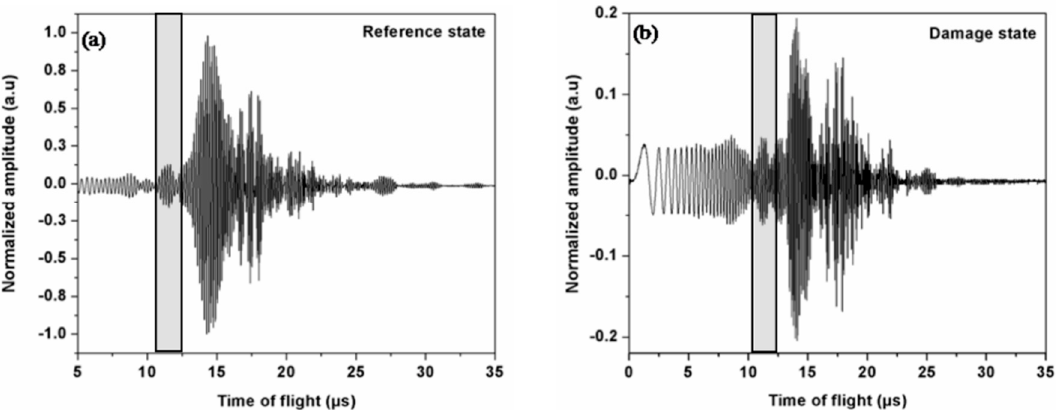
Figure 4. The transient signal of the ultrasonic wave ( a ) in reference and ( b ) damaged sensors excited using chirp signal. The shaded section indicates the selected window of the first arrival wave packet.